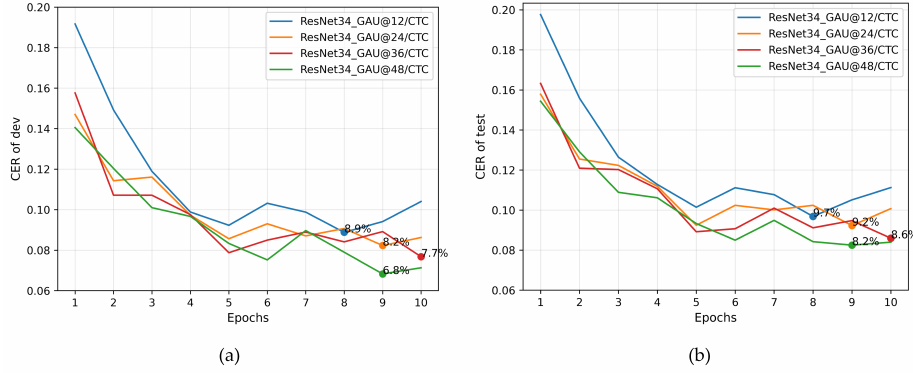
Figure 13. CERs of GAU modules with different layers in the ATC corpus dataset. ( a ) CER of ATC corpus for dev. ( b ) CER of ATC corpus for test.